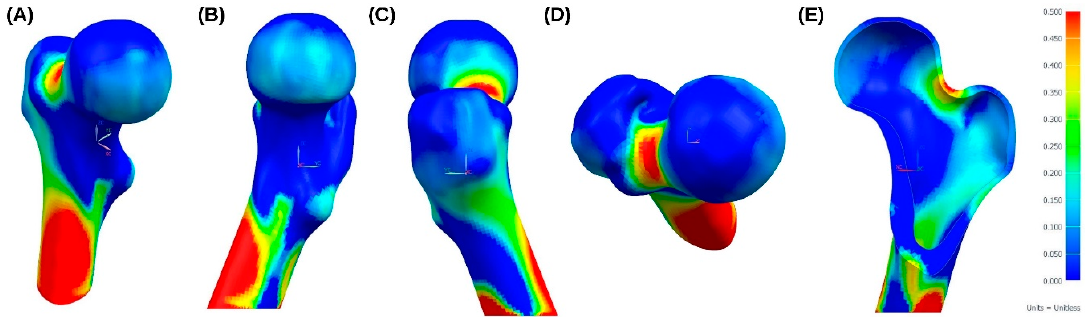
Figure 14. ( A ) Isometric, ( B ) right, ( C ) left, ( D ) top and ( E ) back view of Tsai–Wu field in proximal femur when applying jogging loads.